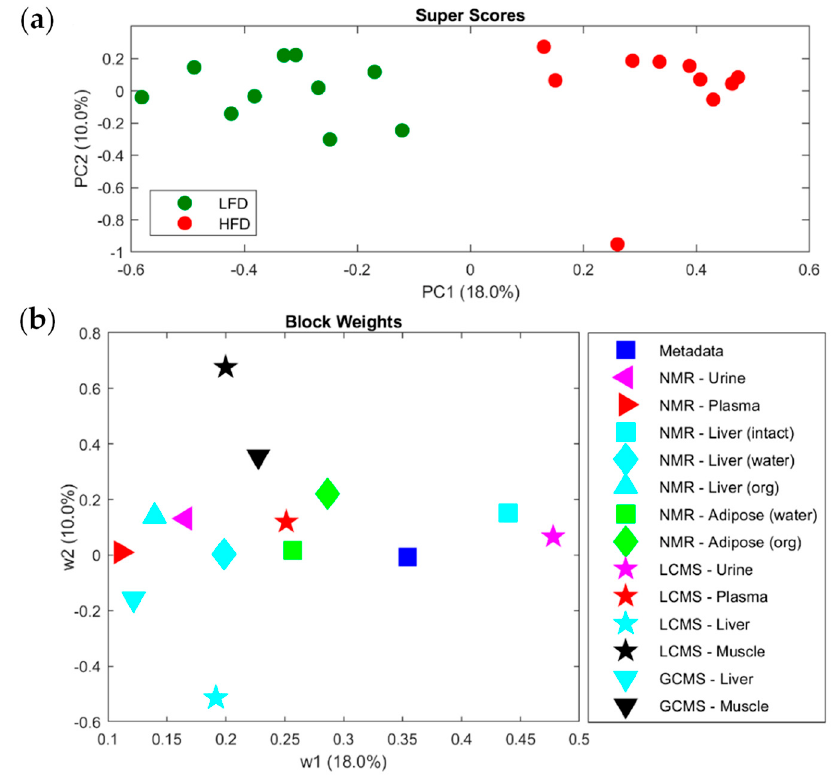
Figure 6. Multi-block PCA super scores plot ( a ) and block weights ( b ) of the body fluids and tissues, considering the metabolomics data obtained from mice fed with a low-fat diet (LFD) and high-fat diet (HFD) [58].